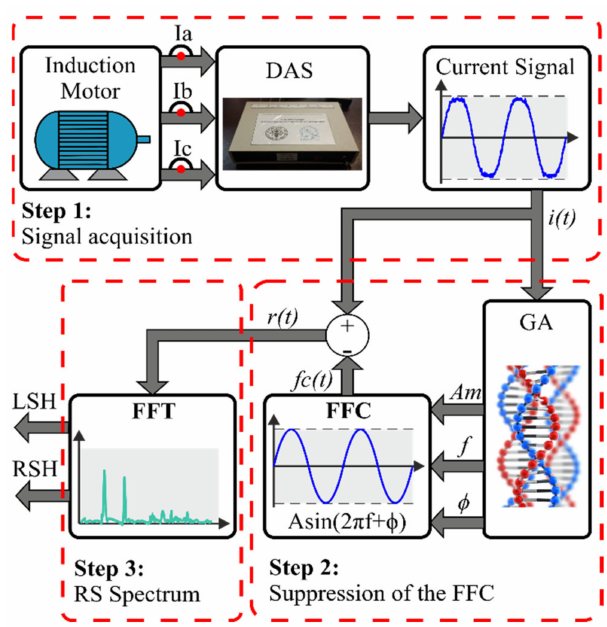
Figure 2. Block diagram of the proposed